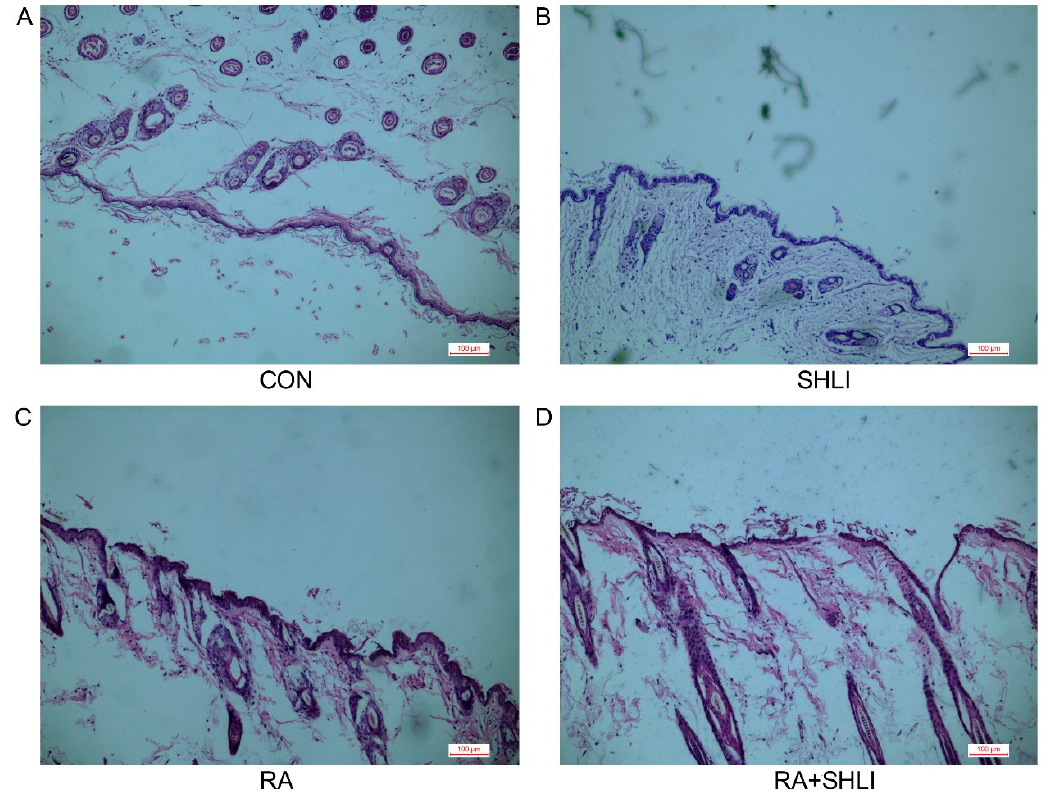
Figure 5. SHLI induced cutaneous adverse reactions because of DSG1 deficiency. ( A – D ) Pathology changes of the skin tissue (HE staining) treated with RA and SHLI.